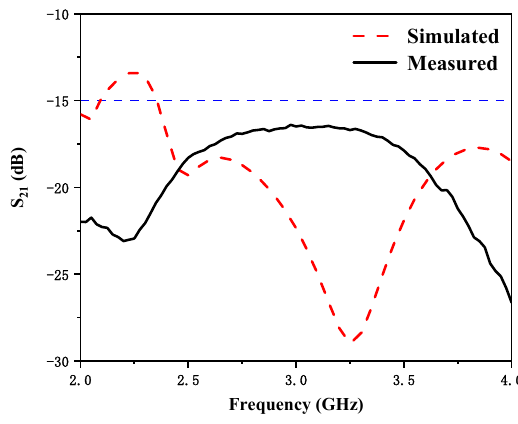
Figure 6. Simulated and measured S 21 of the proposed antenna.